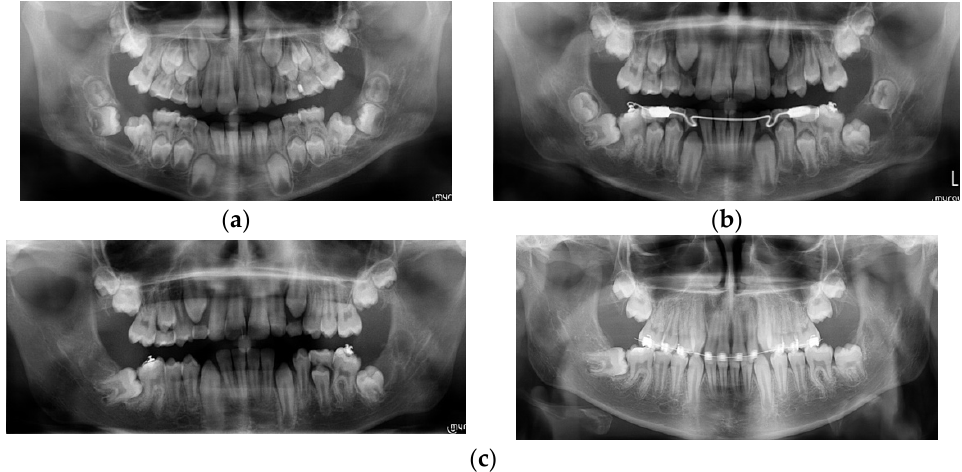
Figure 5. ( a ) Bilateral impaction of lower first and second molars associated with DCs. All four molars presenting abnormal root development, uncorrelated with the age of the patient. ( b ) Orthodontic traction applied from a lingual arch to aid the eruption of the lower first molars. ( c ) Progress records at four months after the removal of both mandibular third